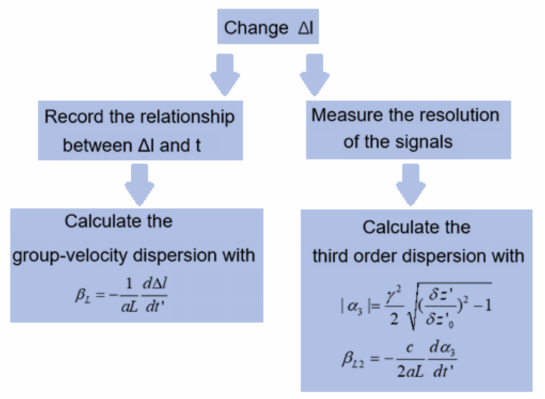
Figure 2. The process of measuring dispersion with OC 2